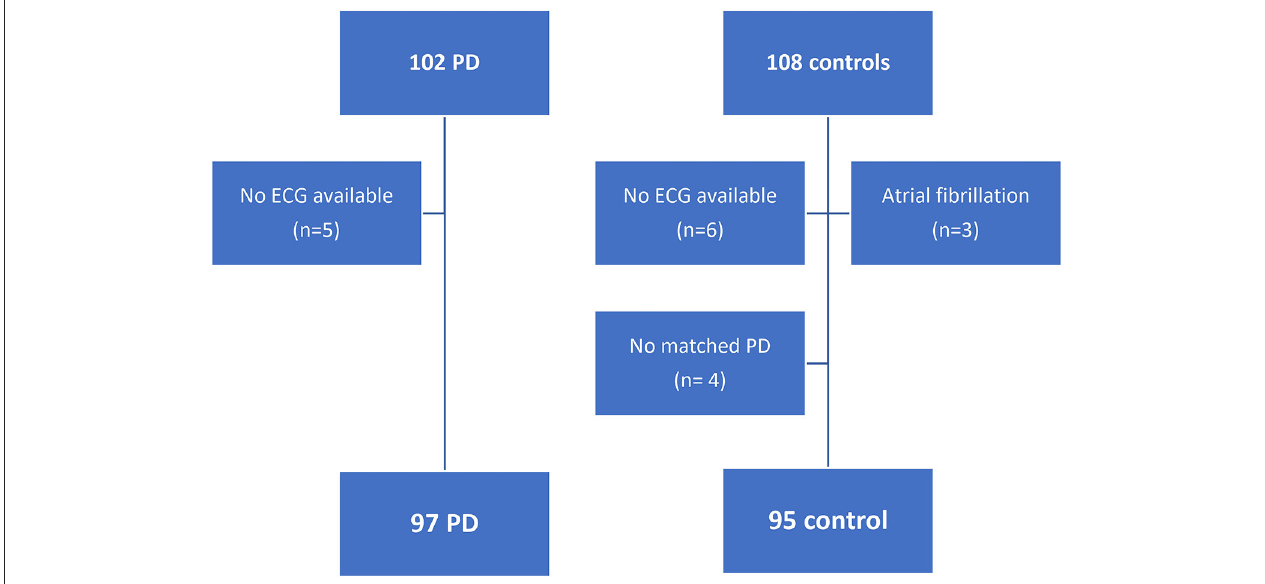
FIGURE 1 | Flowchart of patient’s